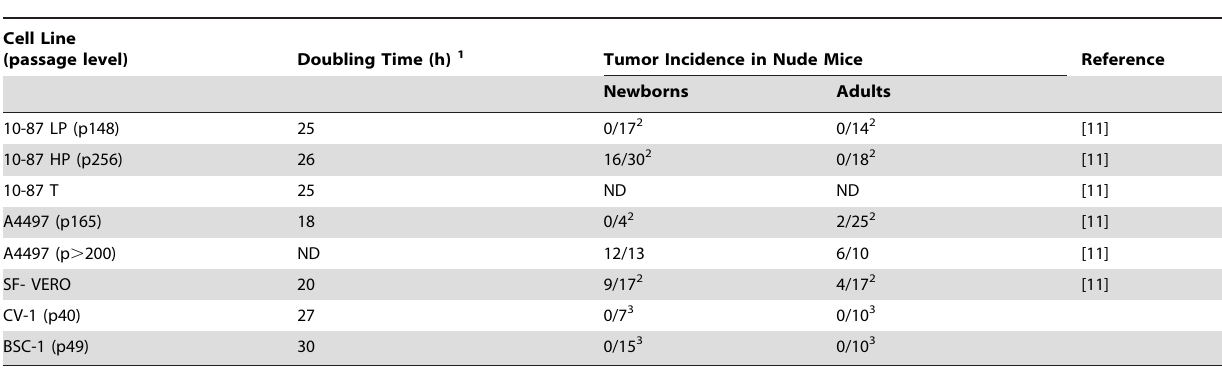
Table 1. Growth rates and tumorigenic characteristics of the cell lines used for miRNA